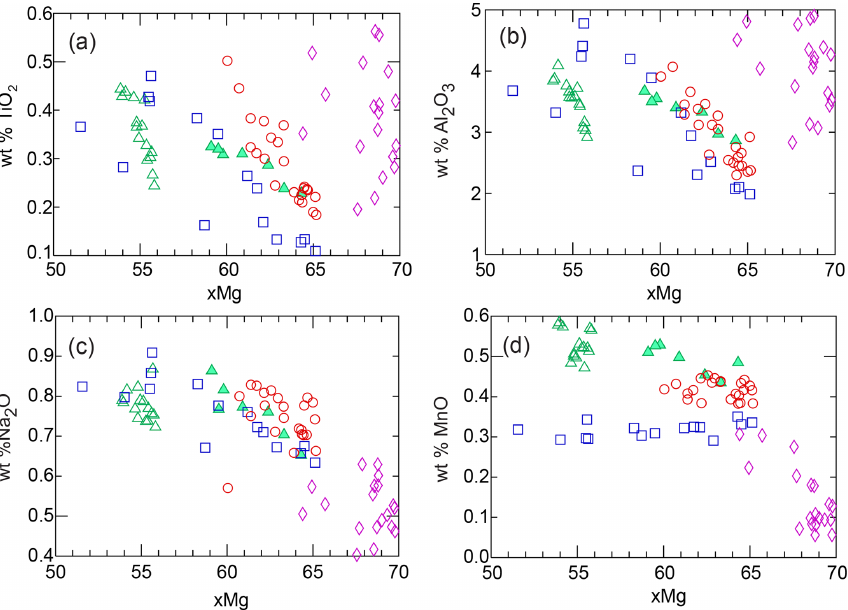
Figure 3. Major element composition of clinopyroxene. (a) xMg vs. weight percent TiO 2 . (b) xMg vs. weight percent Al 2 O 3 . (c) xMg vs. weight percent Na 2 O. (d) xMg vs. weight percent